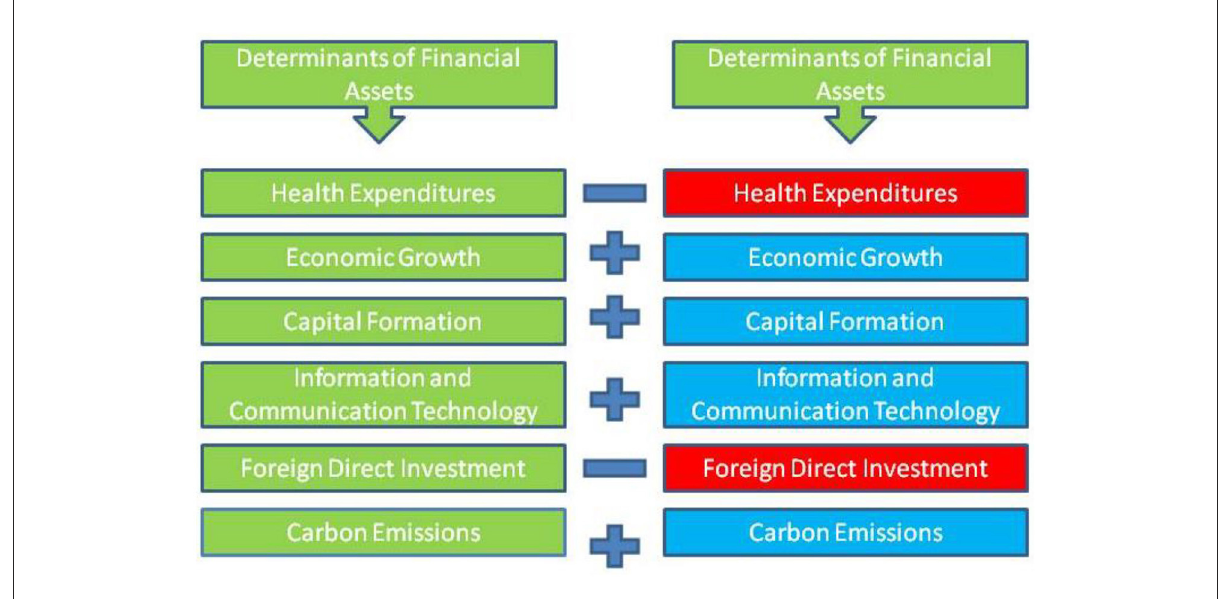
FIGURE2 Graphical presentation of